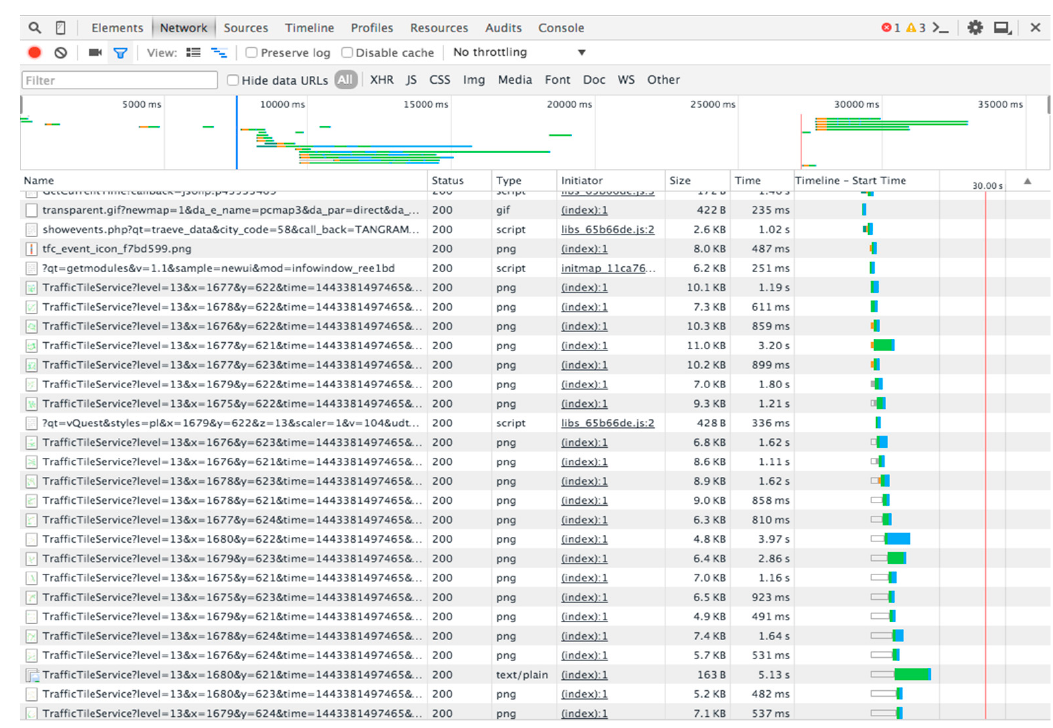
Figure 7. HTTP request analysis by Chrome developer tool.